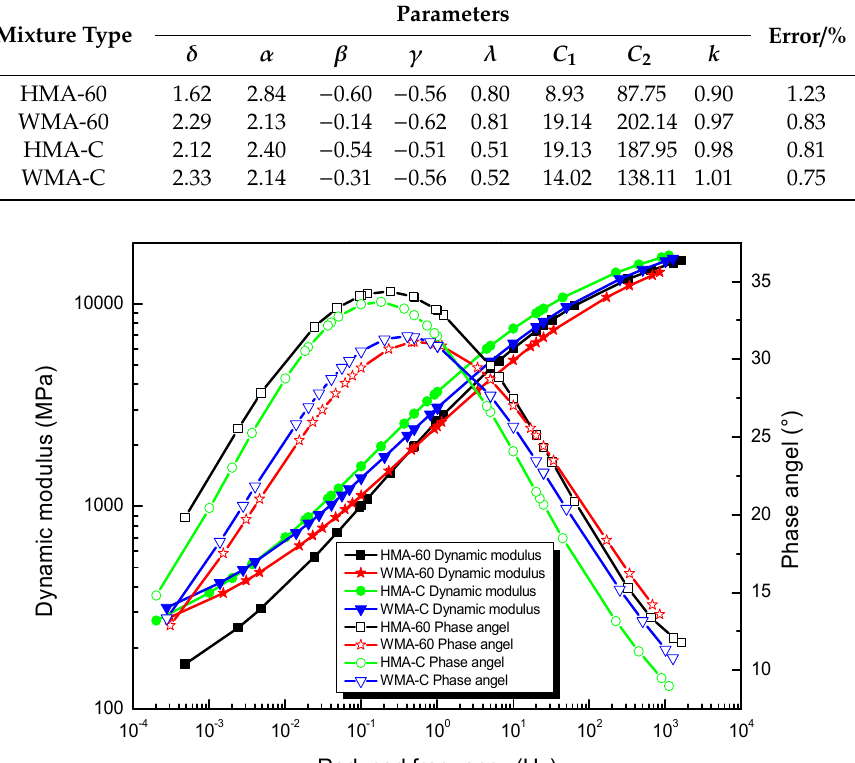
Table 5. GSM fitting parameters for storage modulus and loss modulus.